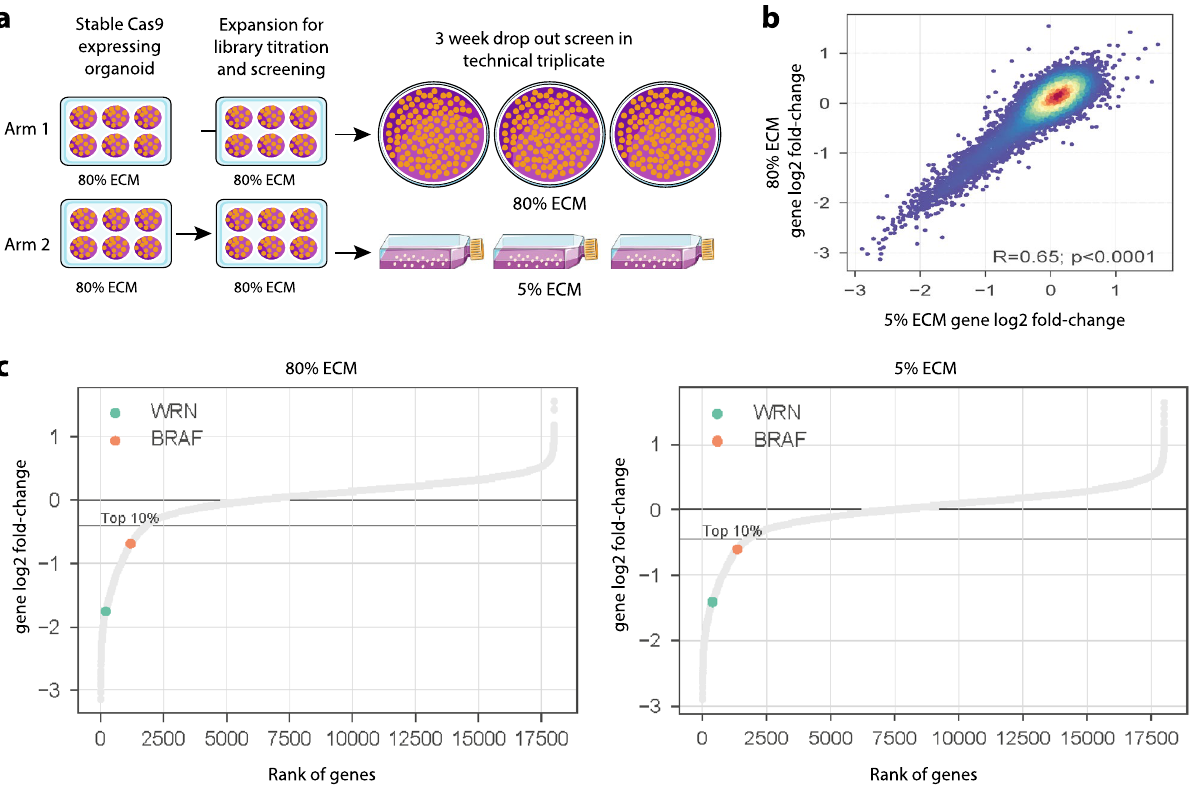
Figure 5. Comparison of CRISPR screening in standard versus low ECM conditions. ( a ) Schematic of the two experimental arms of the whole-genome CRISPR-Cas9 screen in HCM-SANG-0273-C18. ( b ) Spearman’s Rho correlation between 5 and 80% ECM CRISPR-Cas9 screens at the gene level. ( c ) Genes ranked by their log fold change from both experimental arms. WRN and BRAF are highlighted in the top 10% of